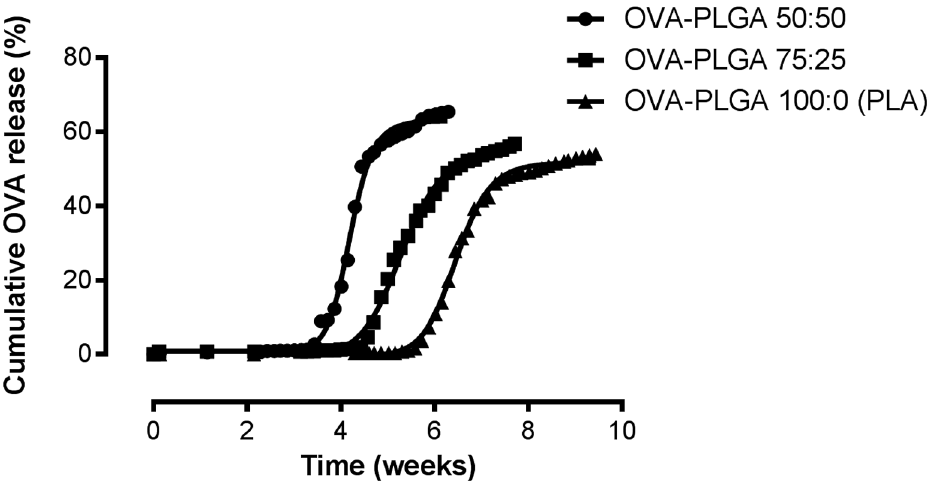
Fig 2. Nonlinear regression analysis of the release of OVA from core-shell implants using PLGA with different lactic to glycolic acid ratios to function as a barrier layer. Calculated ET50 values were 4.2 ± 0.03 weeks, 5.3 ± 0.03 weeks, and 6.5 ± 0.05 weeks for OVA-PLGA 50:50, OVA-PLGA 75:25, and OVA-PLGA 100:0 (PLA), respectively. The difference in ET50 value was statistically significant (P < 0.0001). Results are shown as mean (n = 6).